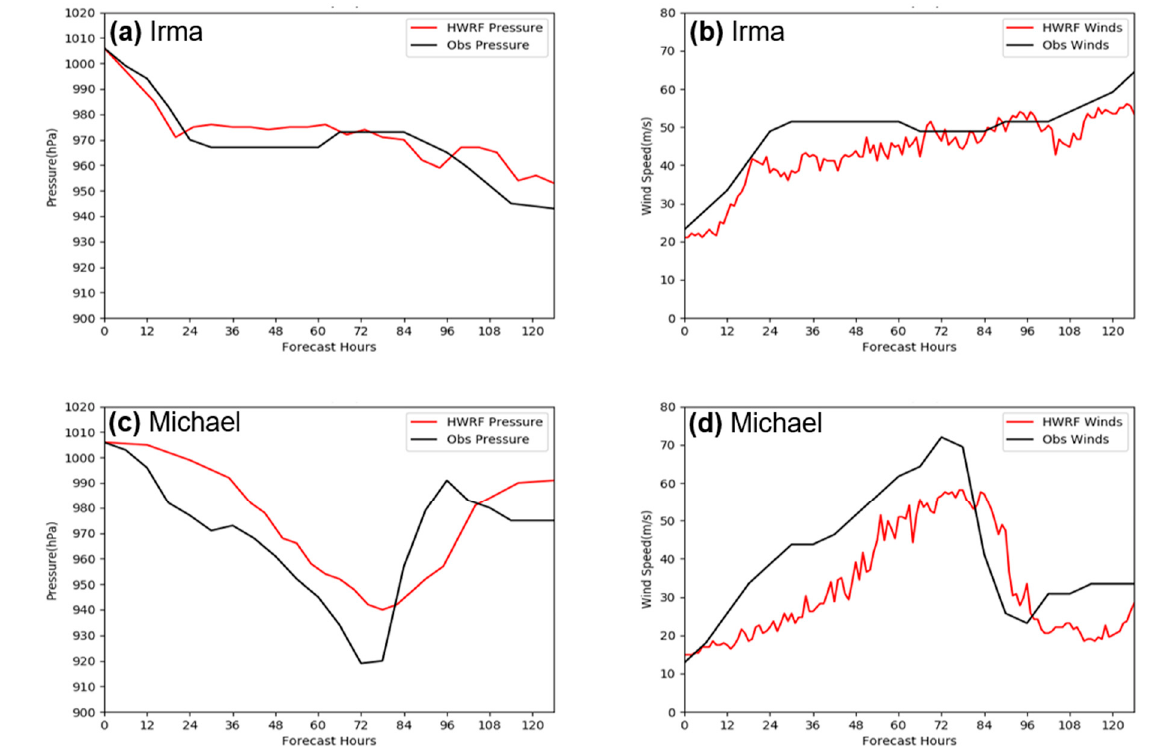
Figure 3. HWRF forecasts (red) are compared with the NHC best track (black) for Hurricane Irma ( a , b ) and Hurricane Michael ( c , d ). The presented features include ( a , c ) minimum mean sea level pressure (hPa) and ( b , d ) maximum 10 m winds (m s − 1 ). The forecasts for Hurricane Irma and Hurricane Michael were initialized at 1200 UTC on 30 August 2017 and 1800 UTC on 06 October 2018, respectively.